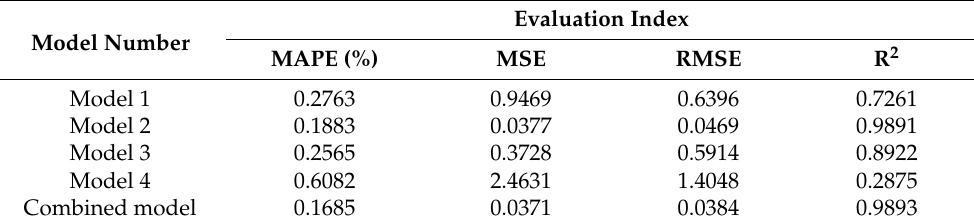
Table 6. Evaluation index values of different models for cumulative displacement.